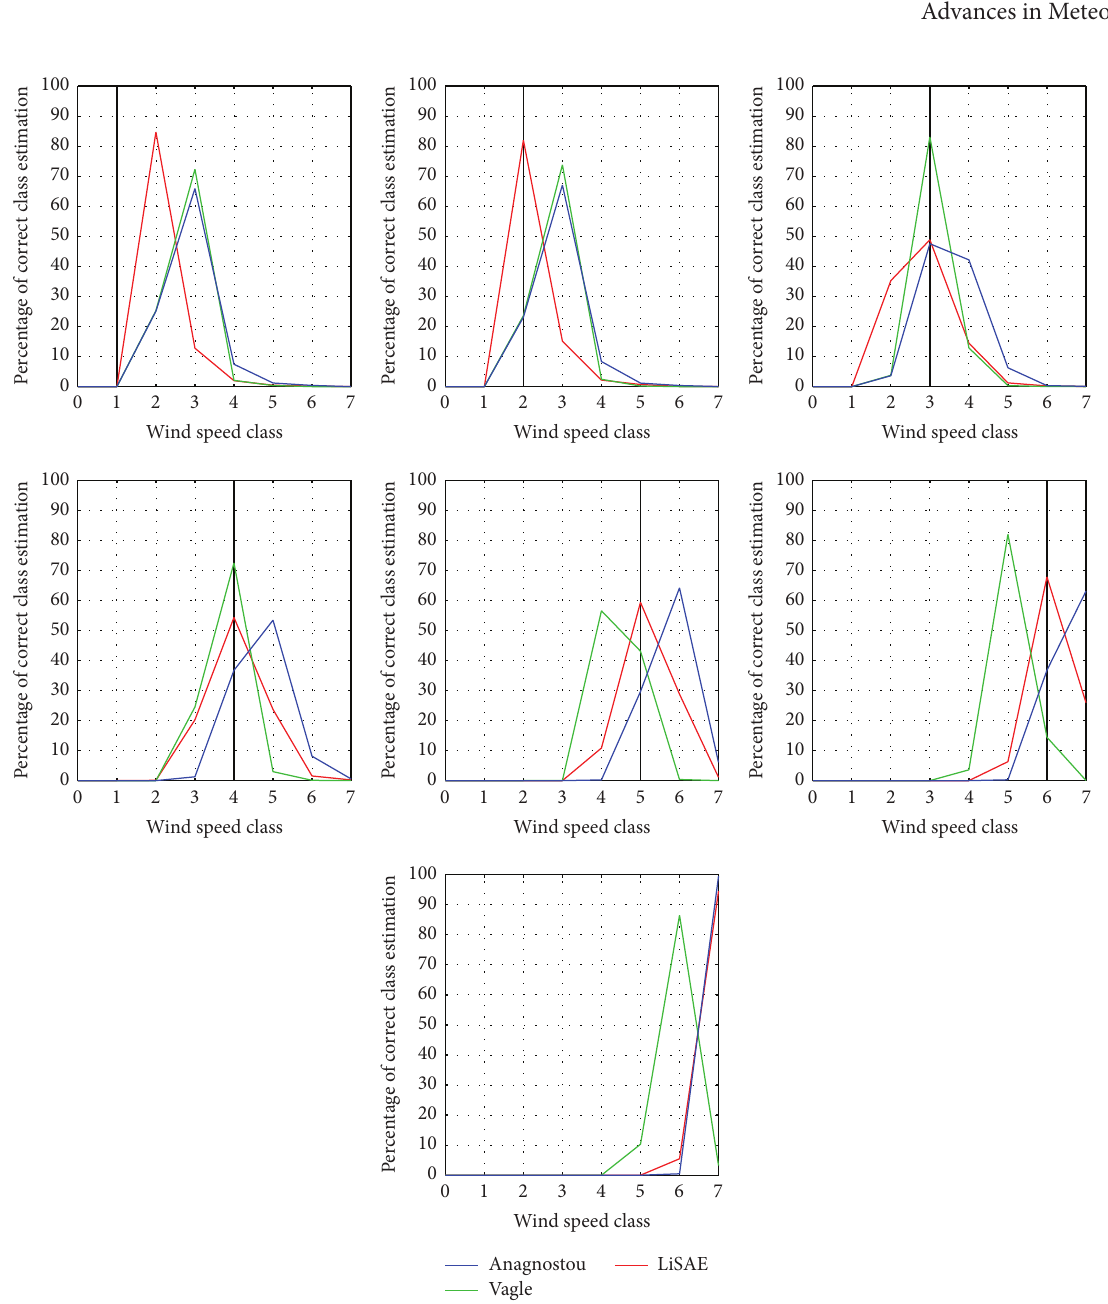
Figure 14: Normalized skill score for the three different parameterizations (LiSAE, Vagle, and Anagnostou) for the wind speed classes F1 to F7. The vertical line identifies the correct